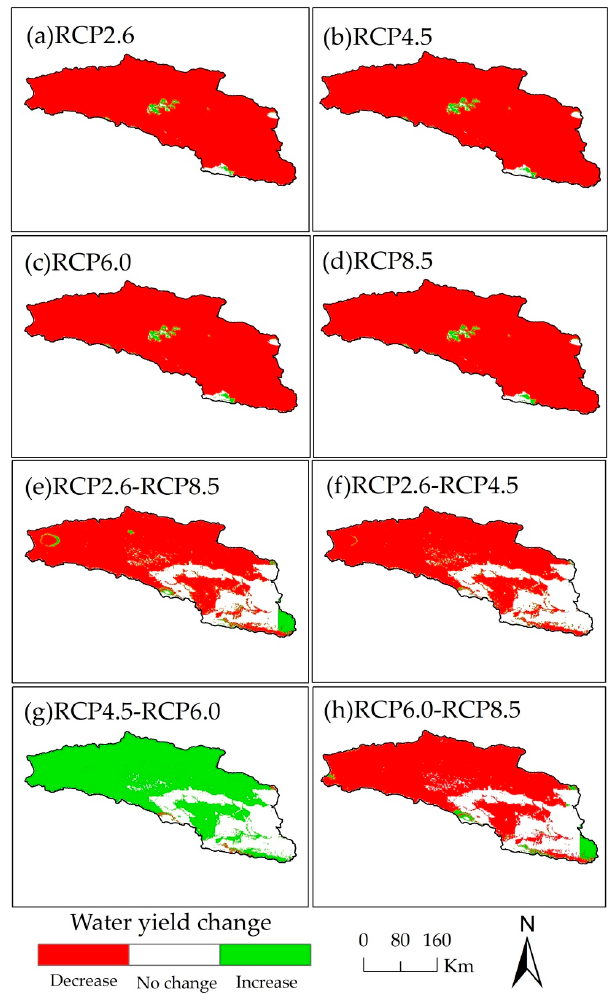
Figure 6. The distribution of water yield change of Bosten Lake basin in 2050 for RCP scenarios and in 2015 ( a – d ). The distribution of water yield change of Bosten Lake basin between different RCP scenarios in 2050 ( e – h ).